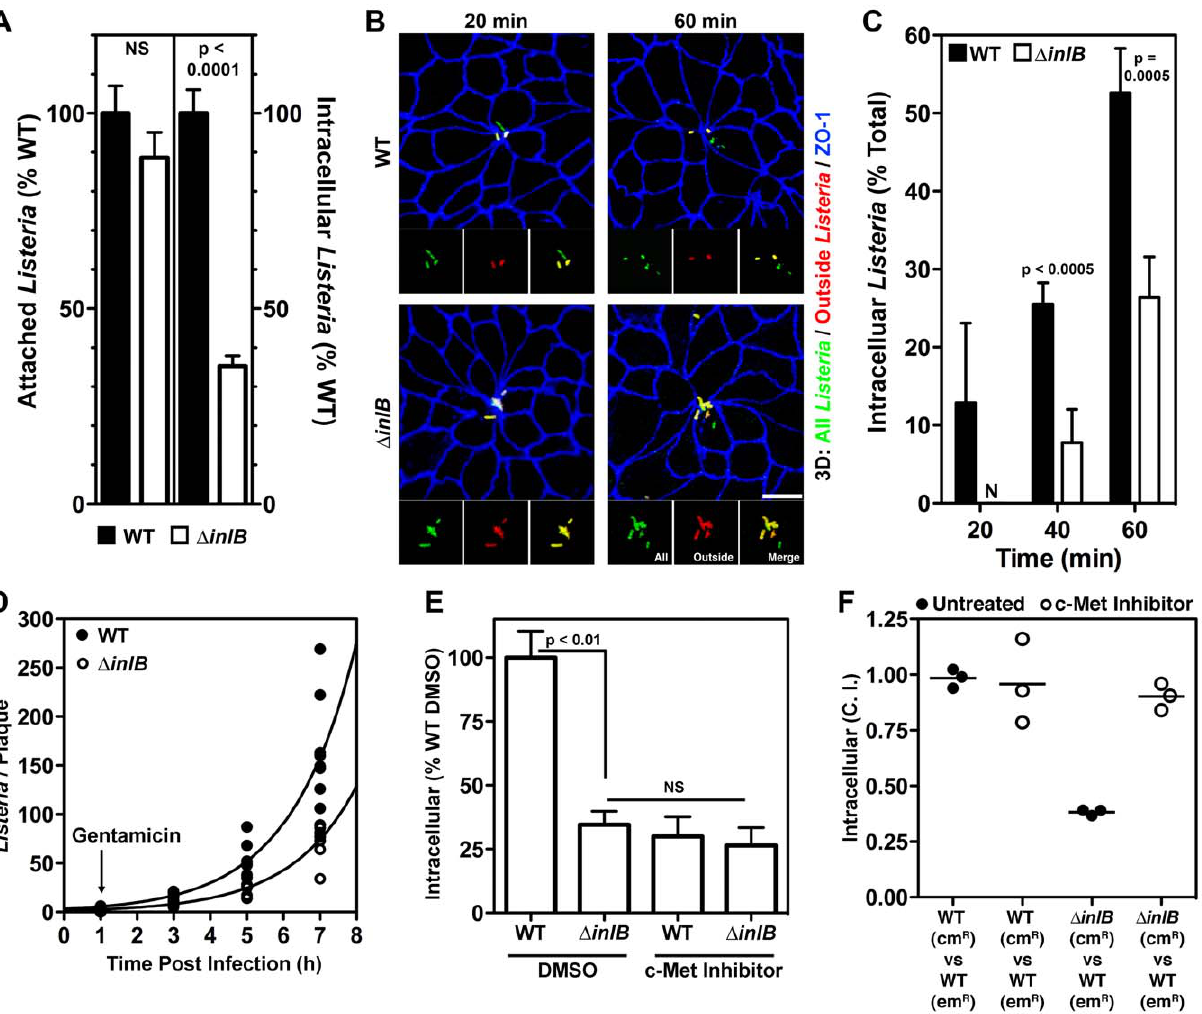
Figure 2. InlB and c-Met accelerate invasion of multicellular junctions. (A) Confluent MDCK monolayers were infected with WT or D inlB Lm at an MOI of 100. Adhesion after 10 min of infection determined by quantification of all cell-associated CFUs, left, or invasion determined by quantification of viable CFUs of intracellular bacteria after gentamicin treatment, right. Mean and SD from a representative experiment performed in triplicate is shown. (B) Polarized MDCK monolayers were infected with an MOI of 10 of GFP-expressing Lm . Invasion at multicellular junctions was visualized with anti-ZO-1 antibodies, blue. To evaluate intracellular versus extracellular bacteria, extracellular adherent GFP-expressing Lm were stained before permeabilization in red. External Lm thus appear as a combination of red/green or yellow. Scale bars 10 m m. (C) Quantification of intracellular bacteria from monolayers as in B. Mean and SD from three 60X fields are shown. (D) Polarized MDCK monolayers infected with an MOI of 10 were fixed at the indicated time points post infection and the number of Listeria per plaque quantified by confocal immunofluorescence analysis. Exponential curves were fit to all data points per strain. WT T d =1.25 h; R 2 =0.818. D inlB T d =1.26 h; R 2 =0.898. (E) Confluent MDCK monolayers were treated with either DMSO or a c-Met inhibitor prior to infection with WT or D inlB Lm at an MOI 100 and quantification of viable CFUs of intracellular bacteria after gentamicin treatment. Mean and SD from triplicate samples are shown. (F) To determine whether the invasion defect of D inlB could be rescued, confluent MDCK monolayers were either untreated or treated with c-Met inhibitor prior and during infection with a 1:1 ratio of WT:WT, as a control, or WT: D inlB at an MOI of 100. The ratio of the strains, competitive index (C.I.), recovered after gentamicin treatment was determined.